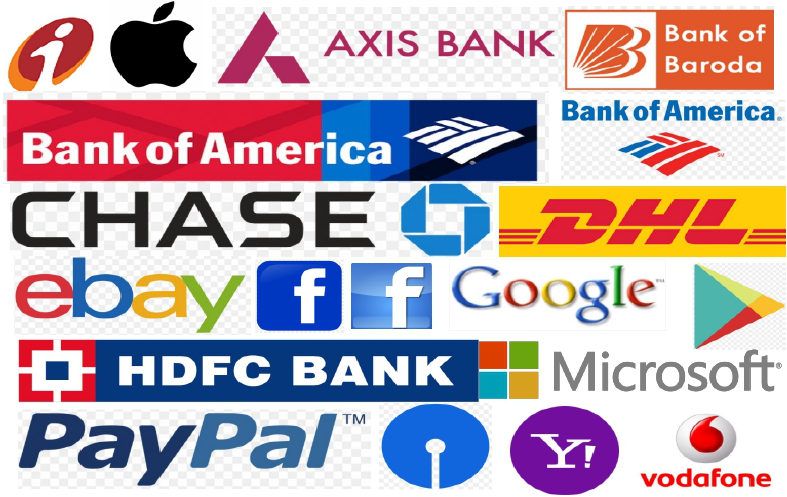
Figure 8. Various logos used in the